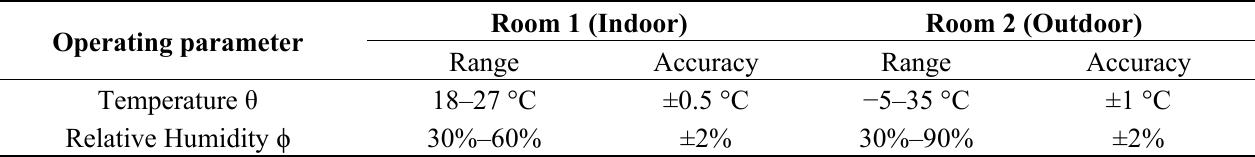
Table 1. Working range and accuracy of the two climatic